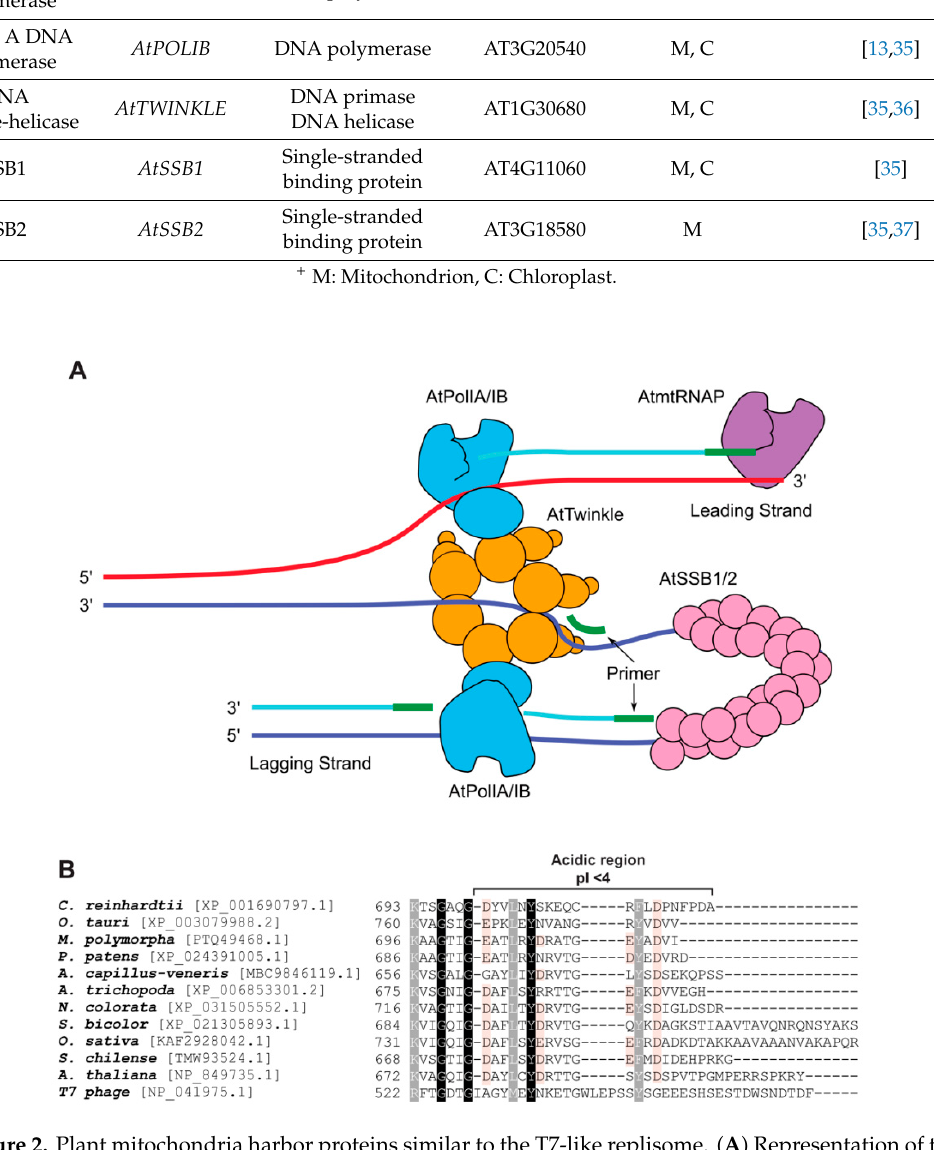
Figure 2. Plant mitochondria harbor proteins similar to the T7-like replisome. ( A ) Representation of the putative T7-like mitochondrial replisome of A. thaliana . The model predicts that in A. thaliana, a plant mitochondrial RNA polymerase (AtmtRNAP) may be involved in primer synthesis. AtTWINKLE is proposed to be involved in the coordination of leading and lagging DNA synthesis by specific interactions with the replicative AtPOLIs. The single-stranded segments are predicted to be covered by AtSSB1 and AtSSB2. ( B ) Amino acid sequence alignment of primases-helicases from plants in comparison to T7 primase-helicase. In both primase-helicases, the C-terminal part is highly acidic, suggesting that AtTWINKLE and AtPOLIs may exert physical interaction via charged residues as in the T7 replisome